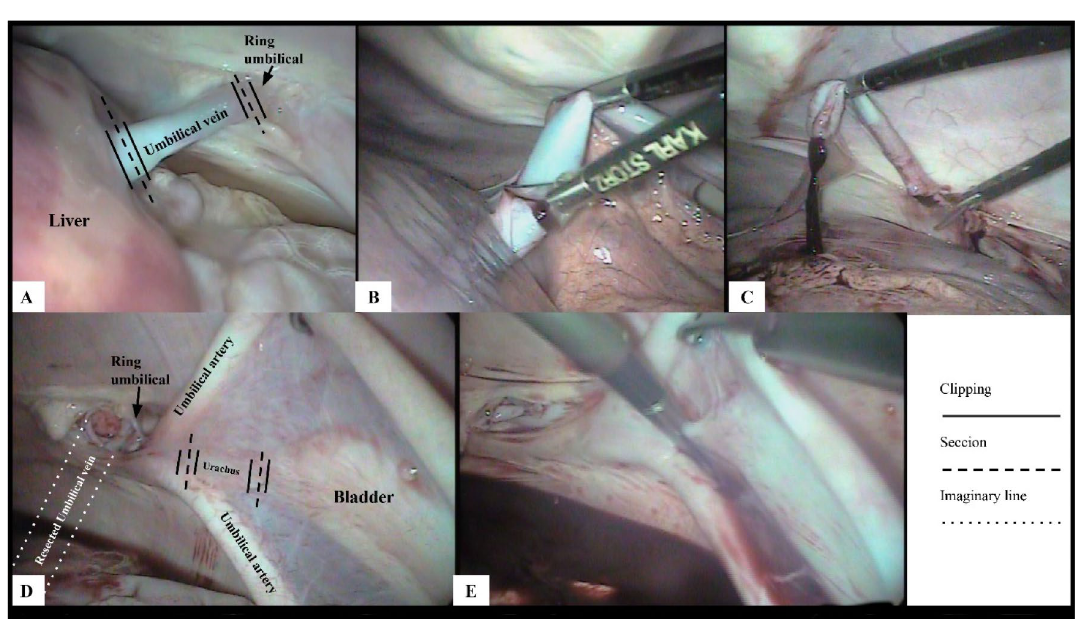
Figure 3. Intra-abdominal resection of the umbilical vein and urachus of bovine fetuses using laparoscopy. ( A – C ) show the steps of umbilical vein resection. ( D , E ) show the steps of urachal